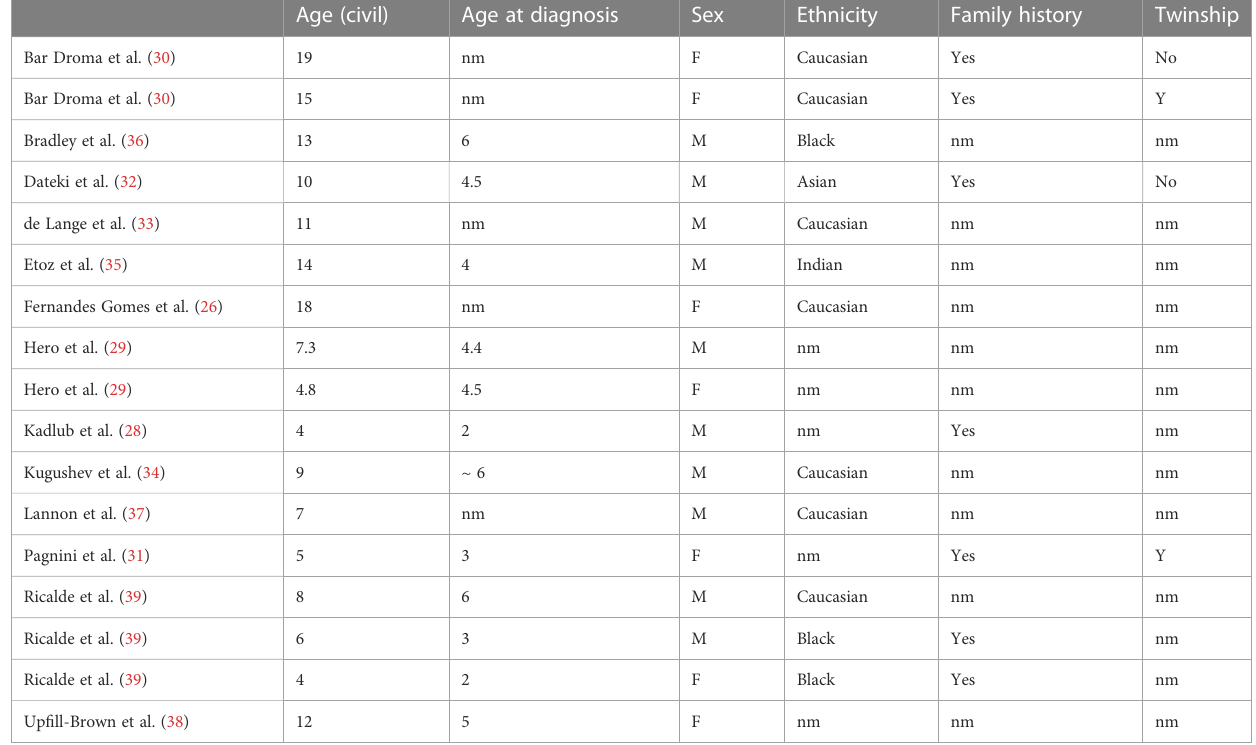
TABLE 2 Patient